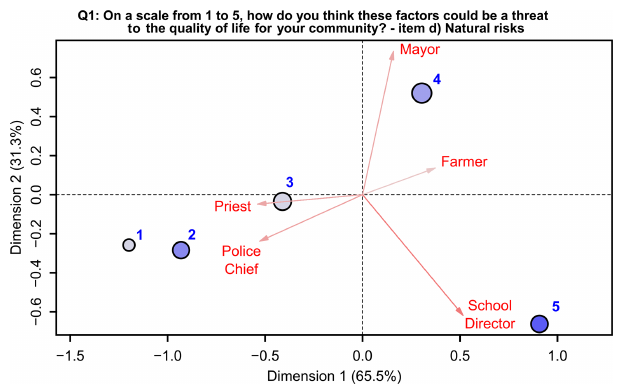
Figure 5. The CA contribution biplot for the natural risks’ role as threats to the community’s quality of life as perceived by the stake- holders according to their type. The orientation of the stakeholder type vector toward one of the axes shows its contribution to the vari- ance of that axis, while the arrow length is proportional with their contribution to the two-dimensional solution. The circles’ colour in- tensity and size (diameter) depend on the relative frequency of the responses on the Likert